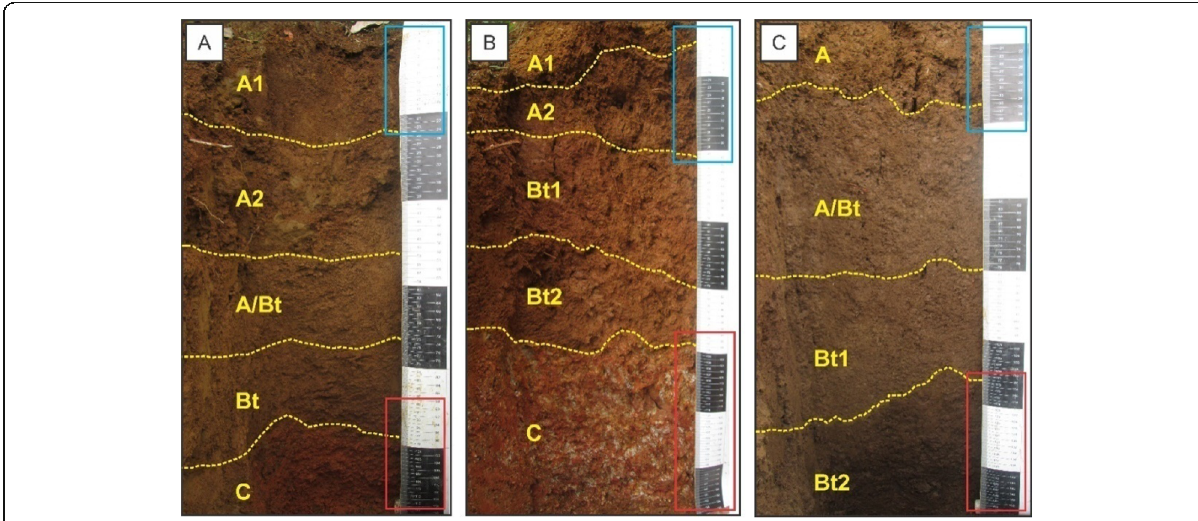
Fig. 6 Soil morphology on the head part of landslide: Tegalsari (b), Wonogiri ( b ), and Manglong ( c ). The blue lines show cracking and difference of soil structure (type of prismatic). The red lines show lithostatic